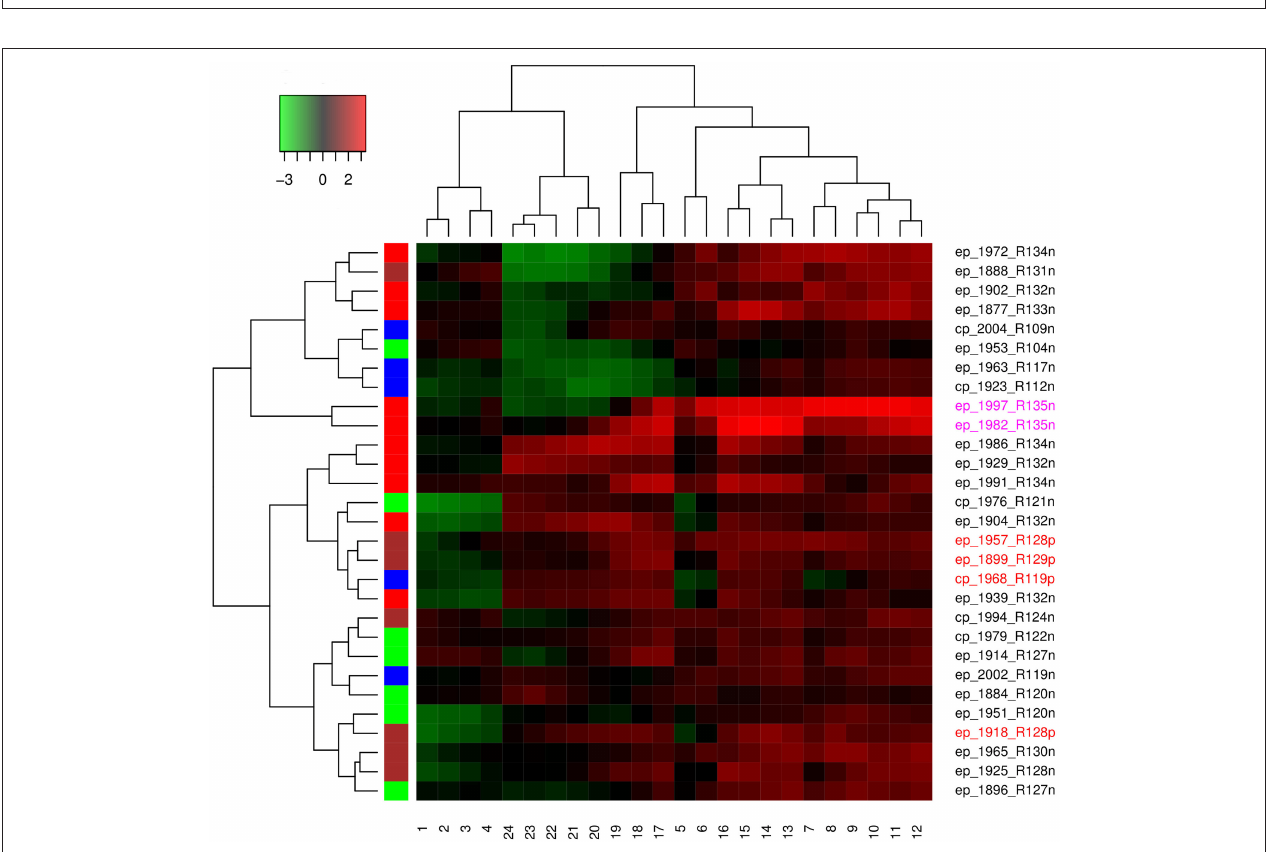
< 0.0001. Post hoc tests showed significant pairwise differences between the three groups, p < 0.0001. ENSO indices for MEI data had low indices from 1 to 5 and 19 to 24 months, but